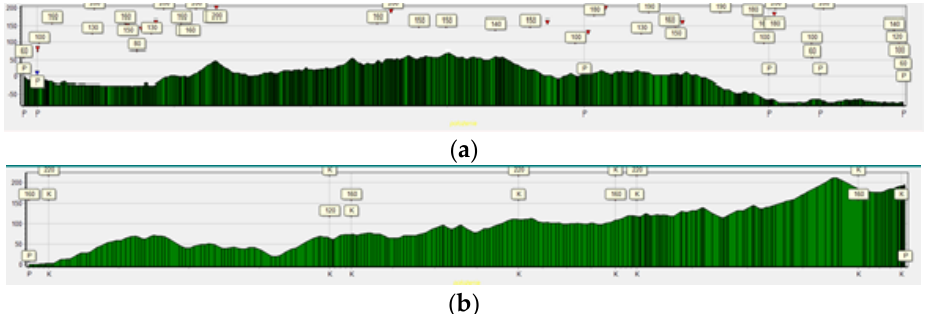
Figure 8. Vertical profile for lines: TI ( a ) and TII ( b ). Source: developed by the authors based on available data.